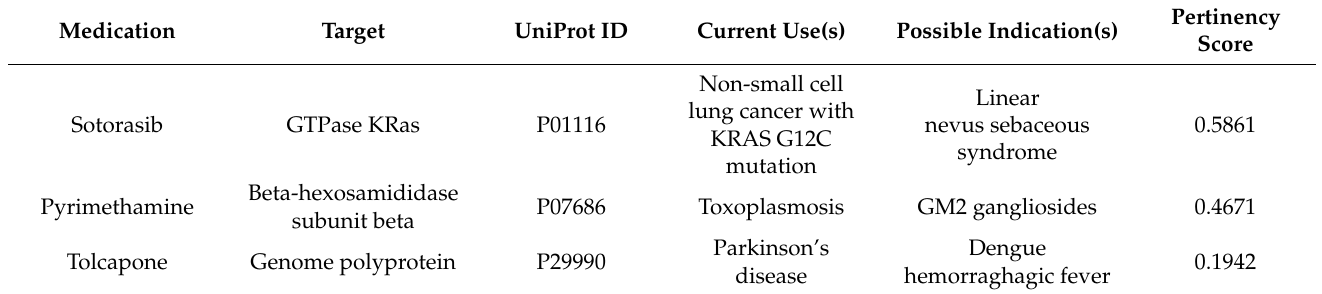
Table 2. Illustrative candidates for drug repositioning across all diseases. For each medication, the protein target, the current use, and the putative indication are listed. The estimated pertinency score for the possible indication is also